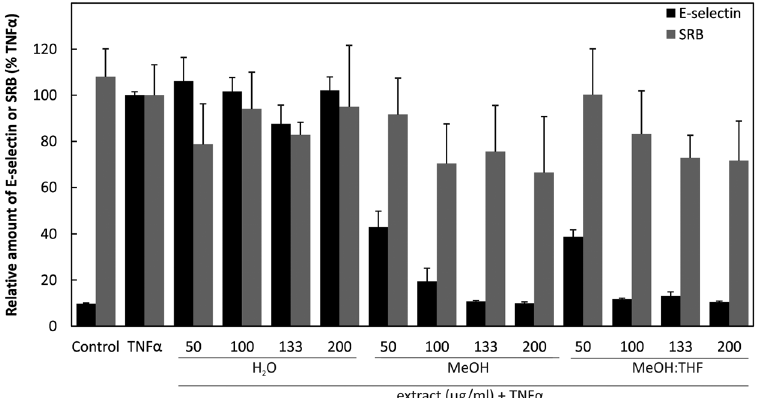
Figure 1. Cell surface ELISA for cell adhesion molecule ELAM. HUVECs were pre-treated with the different extracts from D. cantleyi (50, 100, 133 and 200 µ g/ml as indicated) for 30 min followed by TNF α stimulation for 4 h. Viability was determined by the sulforhodamine B cytotoxicity assay